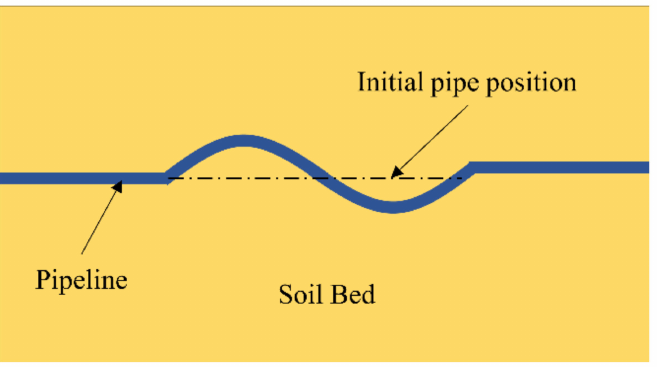
Figure 4. Global lateral buckling or snaking of a surface-laid